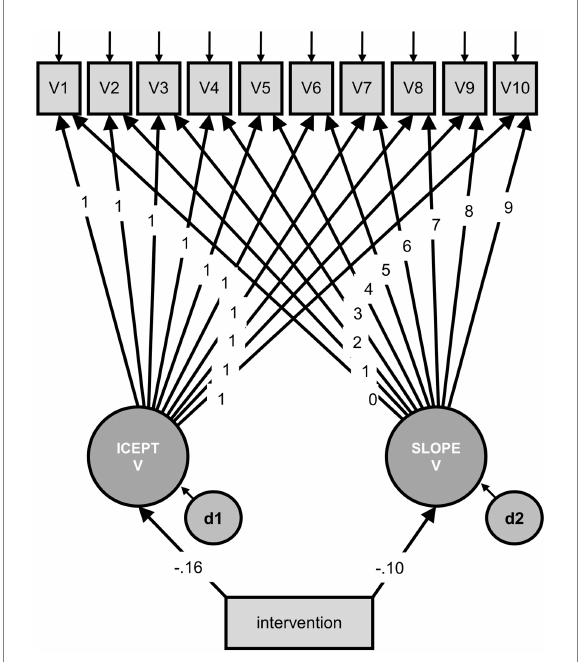
FIGURE 1 Model for valence with intervention as predictor variable. V1– V10 = observed valence, measured at 10 time points, with residuals; ICEPT V = latent intercept of valence, all paths to the observed valence variables were constrained to 1; SLOPE V = latent slope of valence, the paths to the observed valence variables indicate linear growth; d1 and d2 = residuals; intervention = observed predictor variable. Model fit: χ 2 = 65.22, df = 59, p = 0.269; CFI = 0.94; RMSEA = 0.03 (90% CI 0.00–0.06).